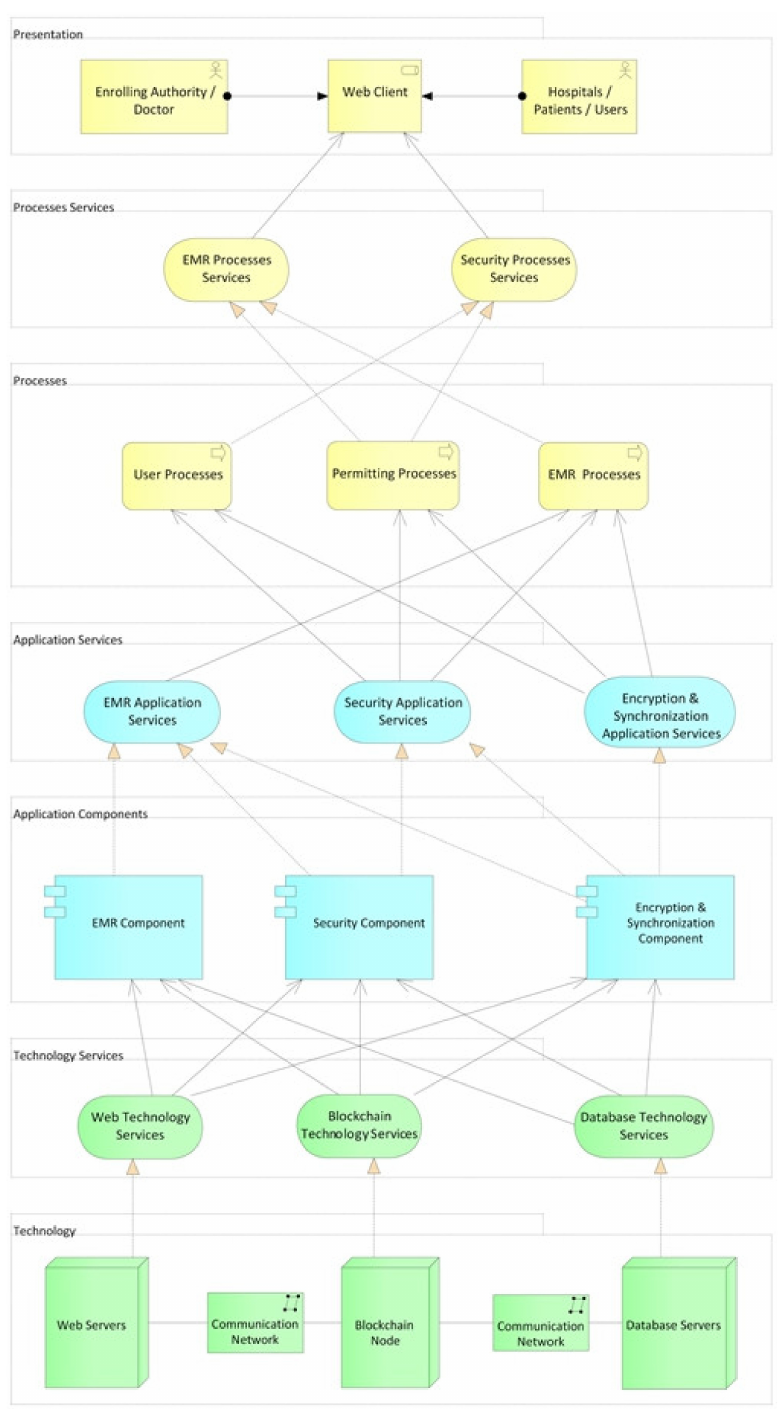
Figure 4. HealthyBlock architecture—layered